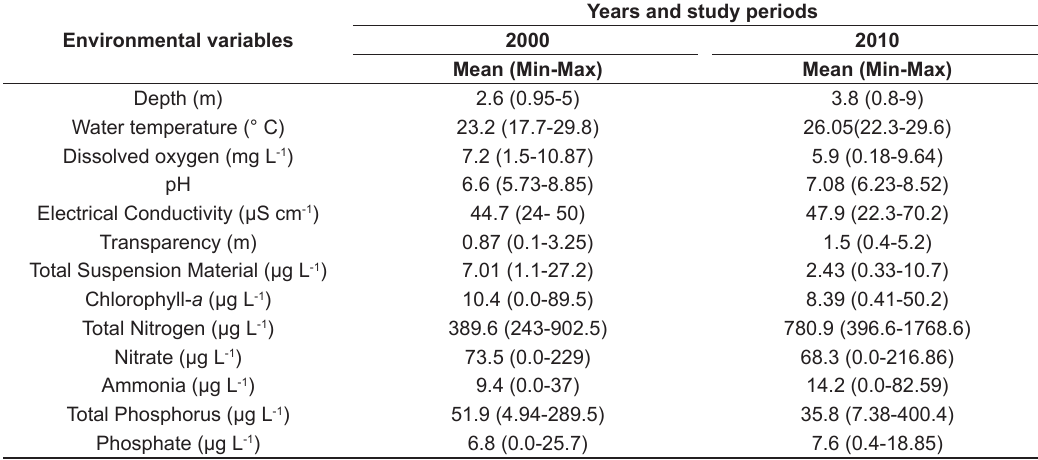
Table 2. Environmental variables (Minimum, Maximum, Mean) recorded during of the months (March and December) of the years studied (2000 and 2010) in the high Paraná river